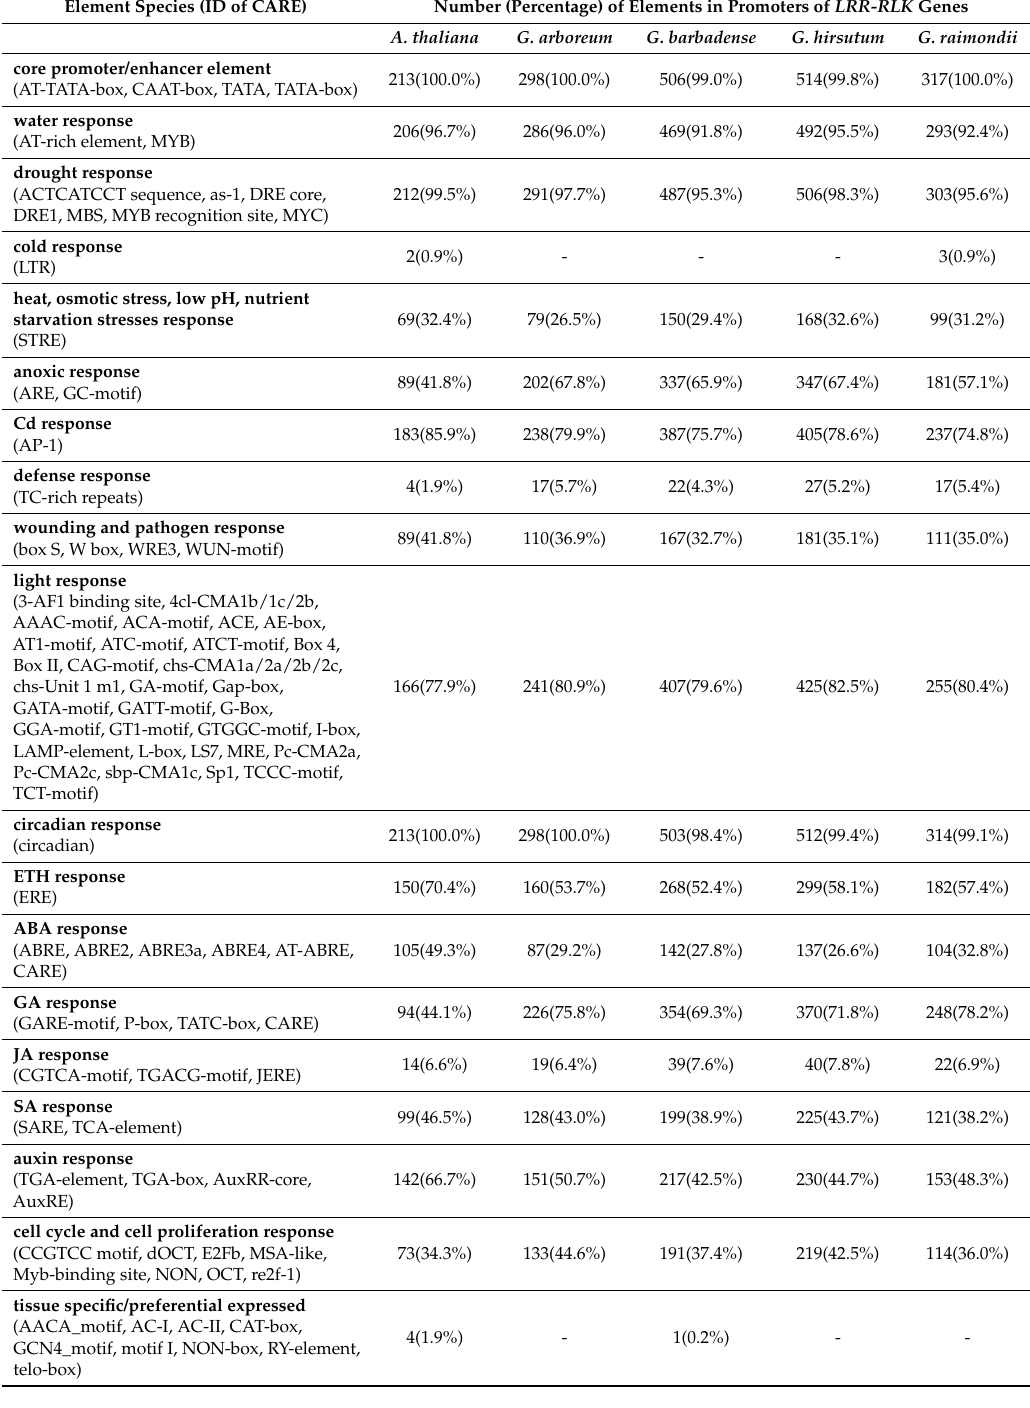
Table 3. Statistics of cis-acting regulatory elements detected in promoter regions of Gossypium LRR-RLK genes. (*cis-acting regulatory elements that have no functional description were not shown, see Table S3 for